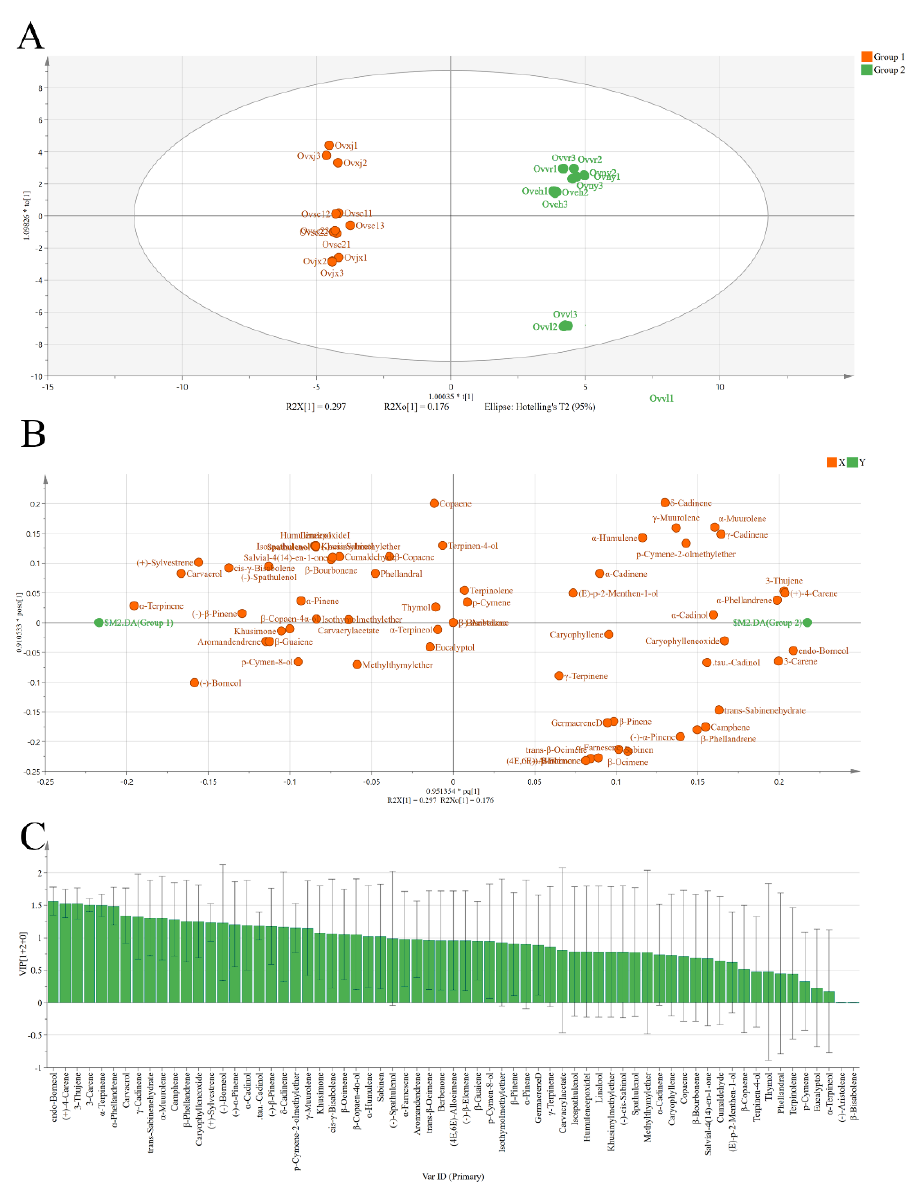
Figure 2. Score plots ( A ), loading plot ( B ), and VIP values ( C ) from OPLS-DA based on the chemical profiles of eight profiles of eight OEOs.